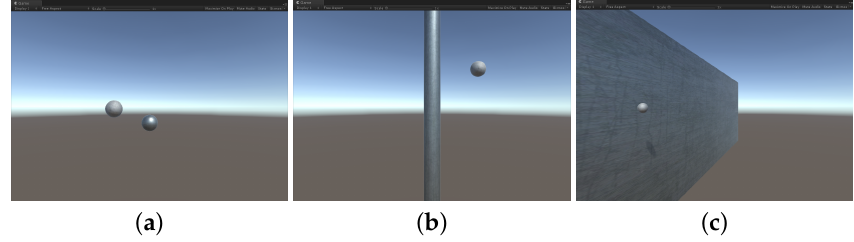
Figure 9. ( a ) Point charge, ( b ) line charge, and ( c ) plane charge